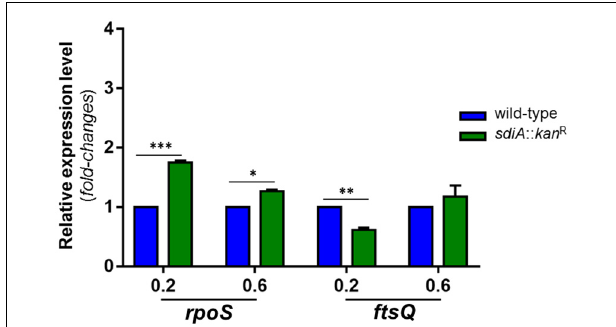
FIGURE 2 | K. pneumoniae depleted of SdiA exhibits up-regulation of rpoS (stationary-phase Sigma factor RpoS) and down-regulation of ftsQ (gene cluster fts of cell division). The expression of rpoS and ftsQ genes was analyzed by RT-qPCR on the wild-type and mutant K. pneumoniae strains cultured at O.D. 600 nm of 0.2 and 0.6. Error bars represent the standard deviation. Statistically significant differences between the strains were analyzed by multiple t -test (* p < 0.05; ** p < 0.01; *** p <